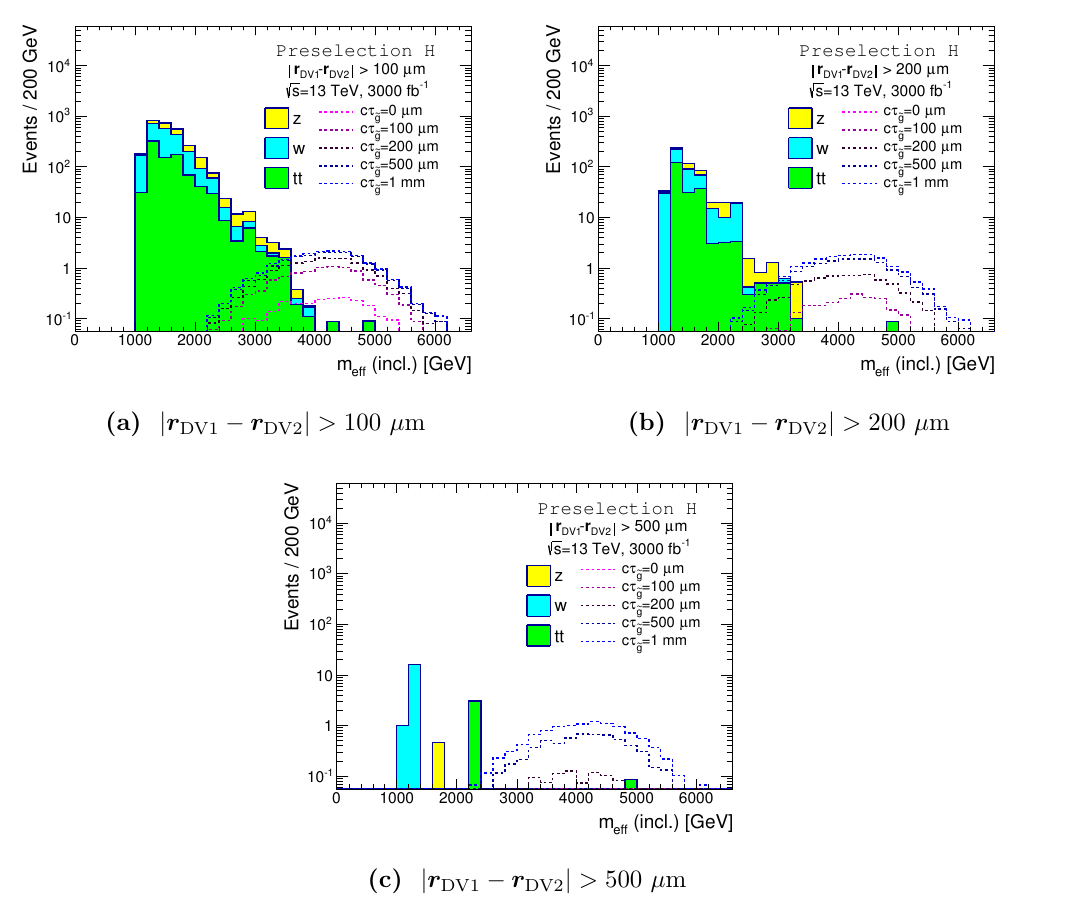
Figure 8. Distributions of m e(cid:11) (incl : ) for the SM background and signal events with di(cid:11)erent values of c(cid:28) ~ g . The masses of gluino and the LSP are set to be 2600 GeV and 100 GeV, respectively. We have imposed preselection-H and the vetoes given in table